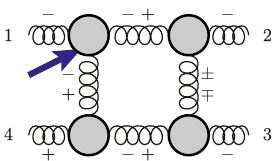
Constraints Parameters left Symmetry of ( p ) 32 p 1 3 ↔